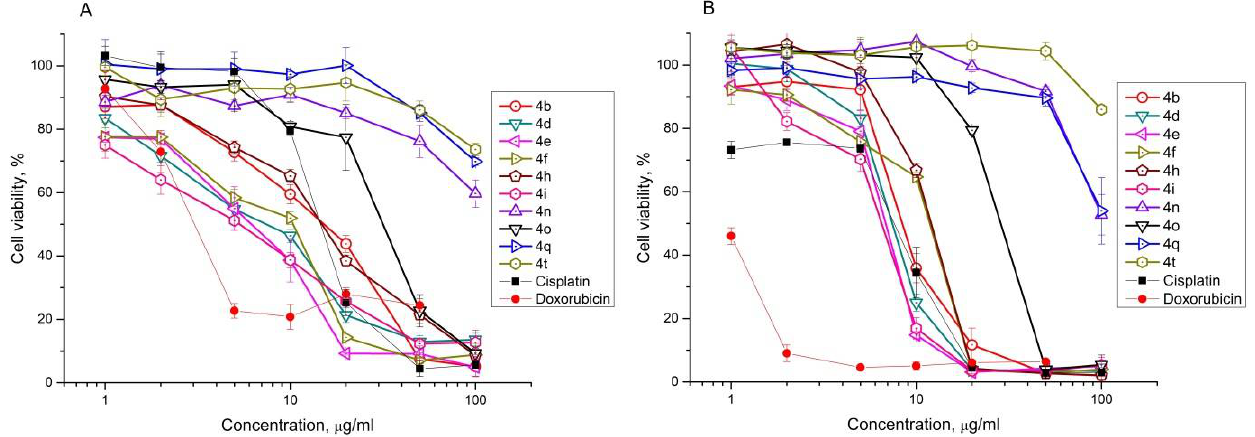
Figure 2. Cytotoxicity of selected 3-azaspiro[bicyclo[3.1.0]hexane-2,5′-pyrimidines] 4 against HeLa cell line for 24 h ( A ) and 72 h ( B ).